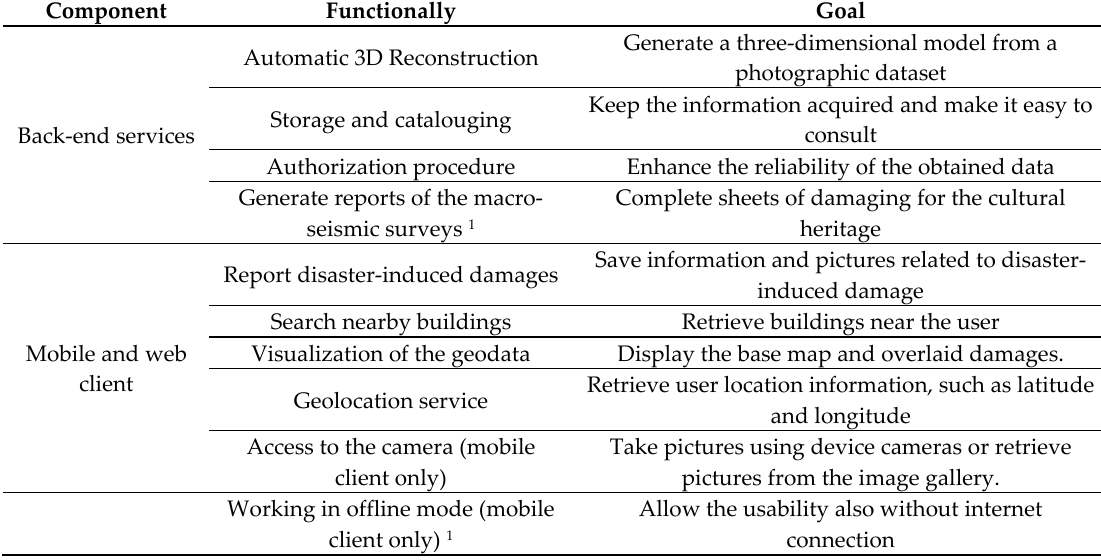
Table 1. Key functionalities identified through the requirement